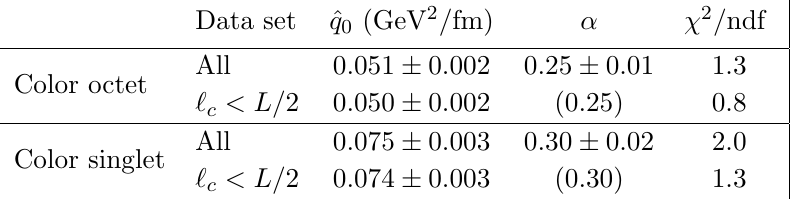
. Experiments are plotted in ?